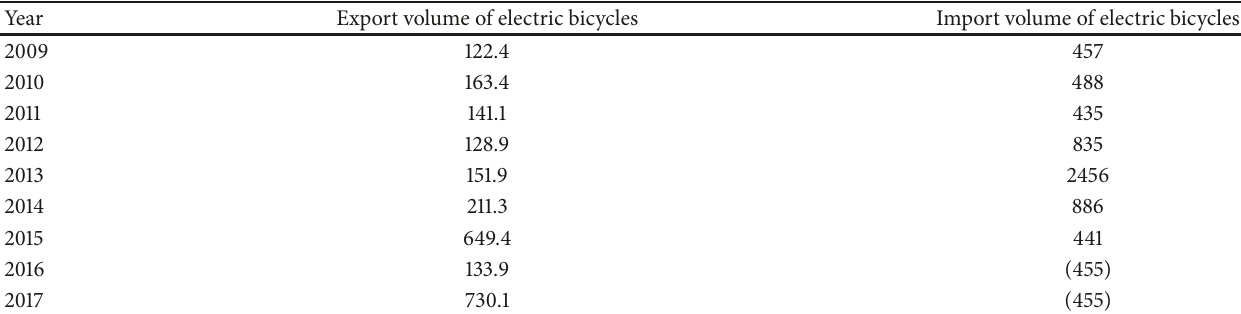
Table 5: Import and export volume of electric bicycles (unit: 10,000